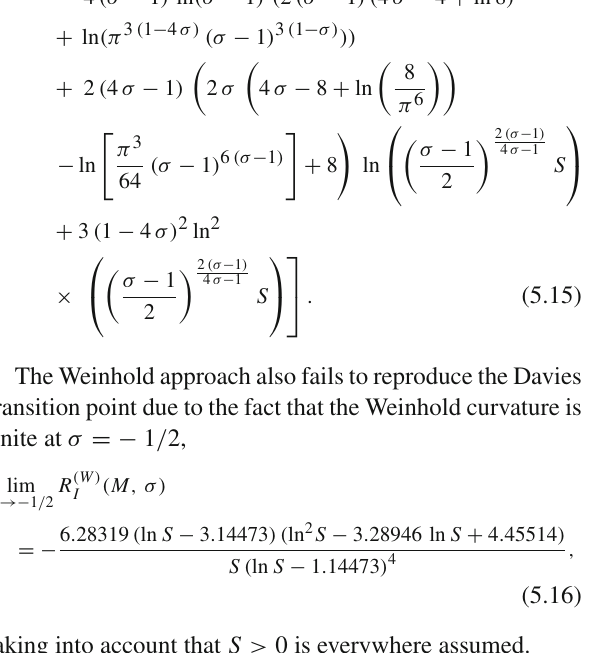
are shown on Fig. 1. The upper region is constrained